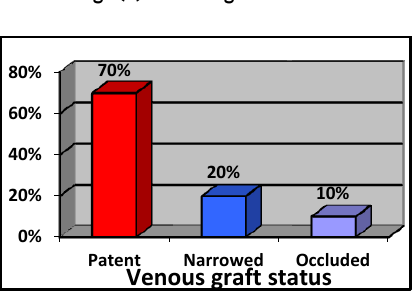
Fig. (2): Radial graft status.